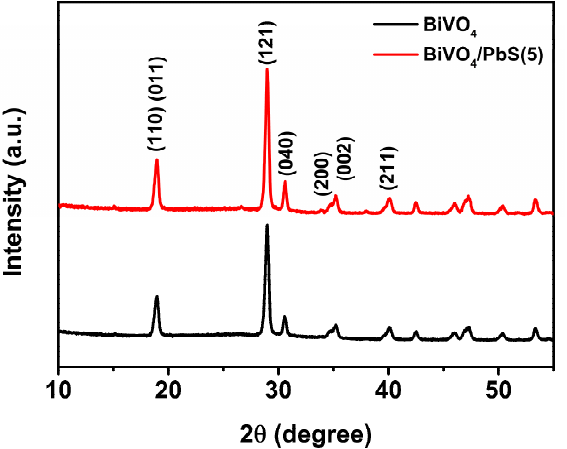
Figure 4. XRD spectra of bare BiVO 4 and BiVO 4 /PbS QDs films on FTO glasses.